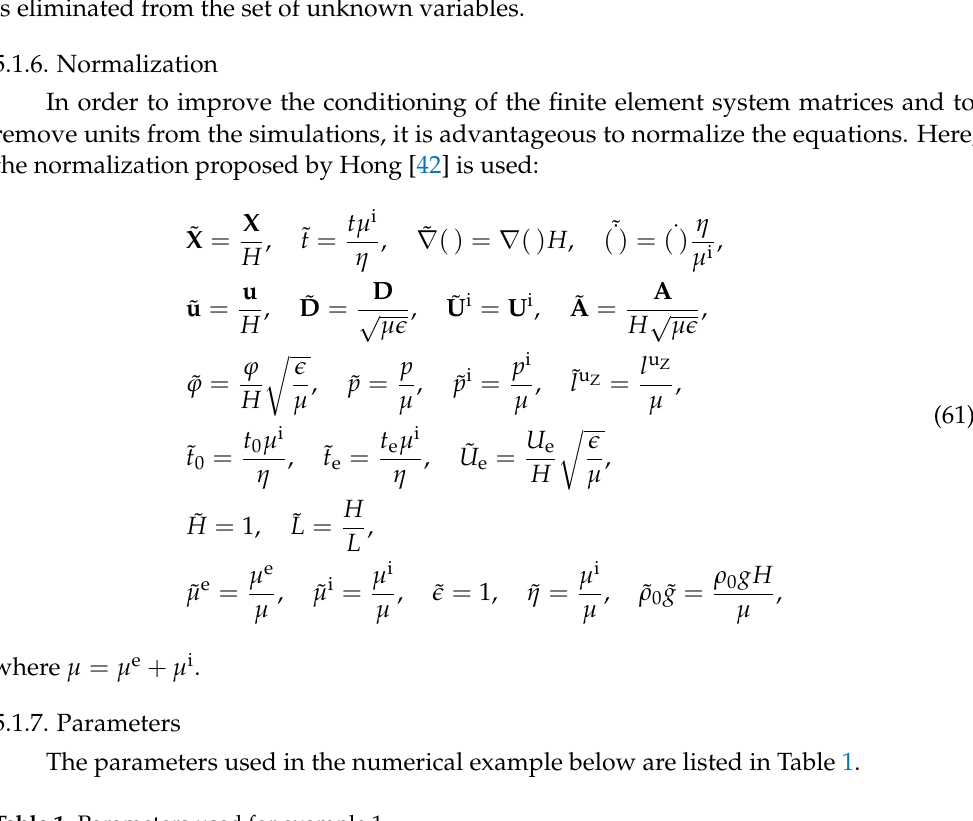
Table 1. Parameters used for example